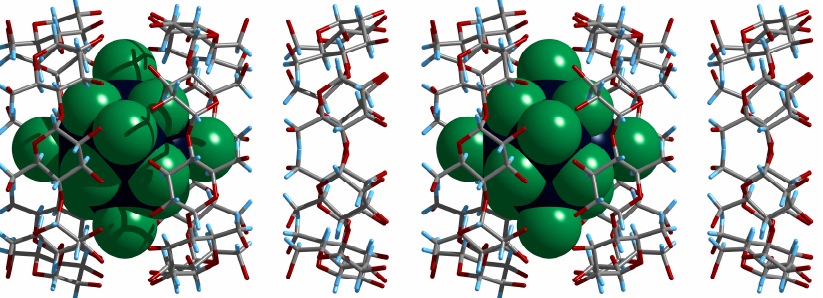
Figure 3. Selected fragment of the crystal structure of Mo 6 Cl 14 @2CD·CD . Mo—dark blue, Cl—green, O—red, C—gray, H—light blue. Disordering of the cluster is omitted for clarity.